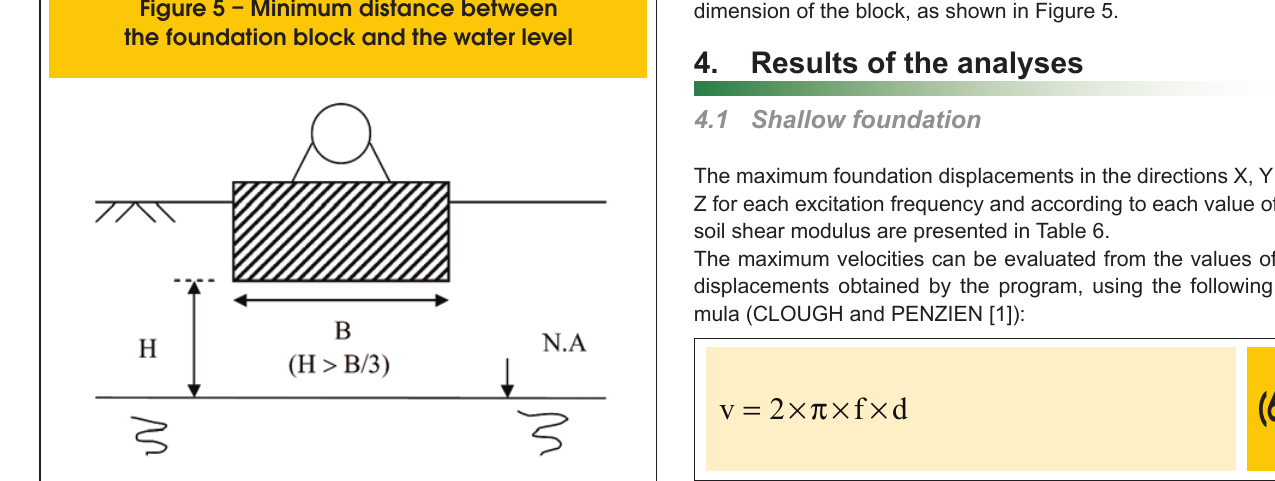
Figure 5 – Minimum distance between the foundation block and the water